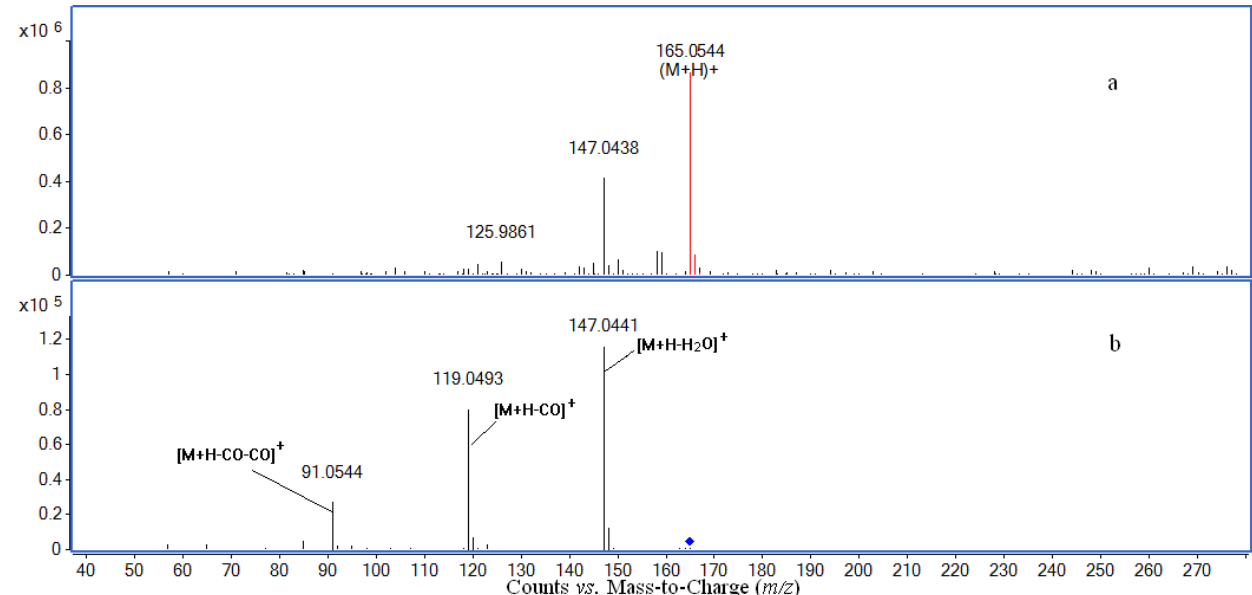
Figure 4. ESI-MS ( a ) and MS/MS ( b ) spectra of p -coumaric acid.